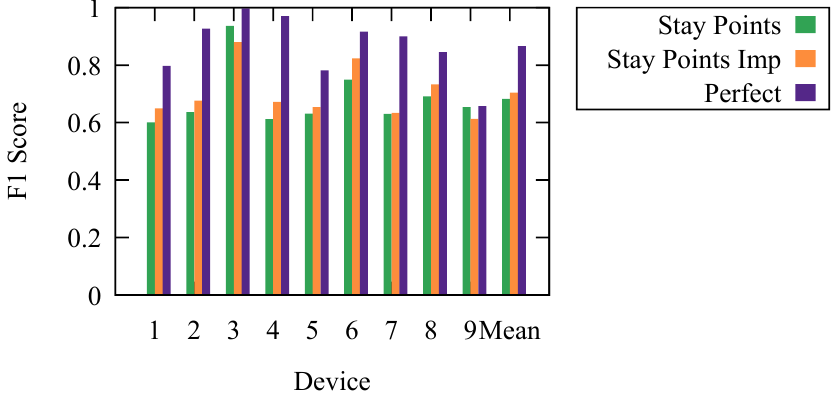
Figure 7. Comparing